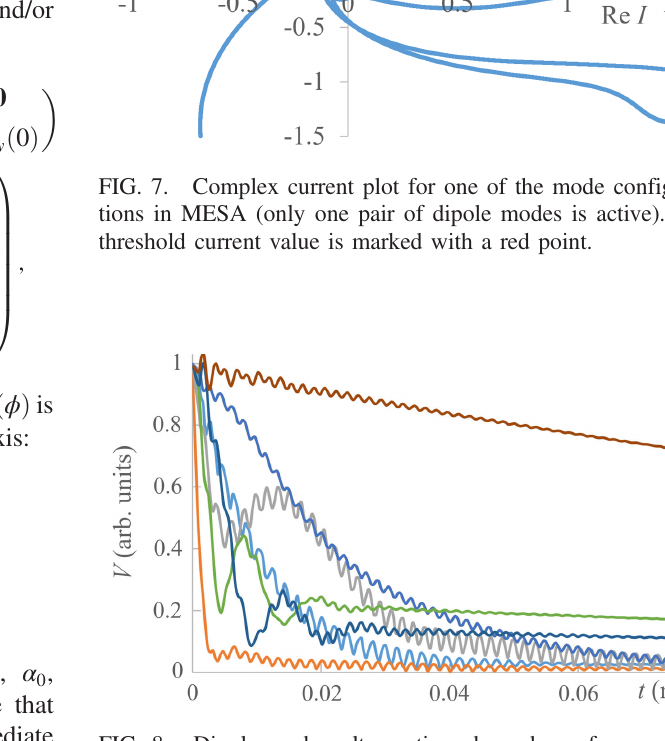
FIG. 8. Dipole mode voltages time dependence for a current 10% below the threshold. Mode configuration is the same as in Fig. 7.